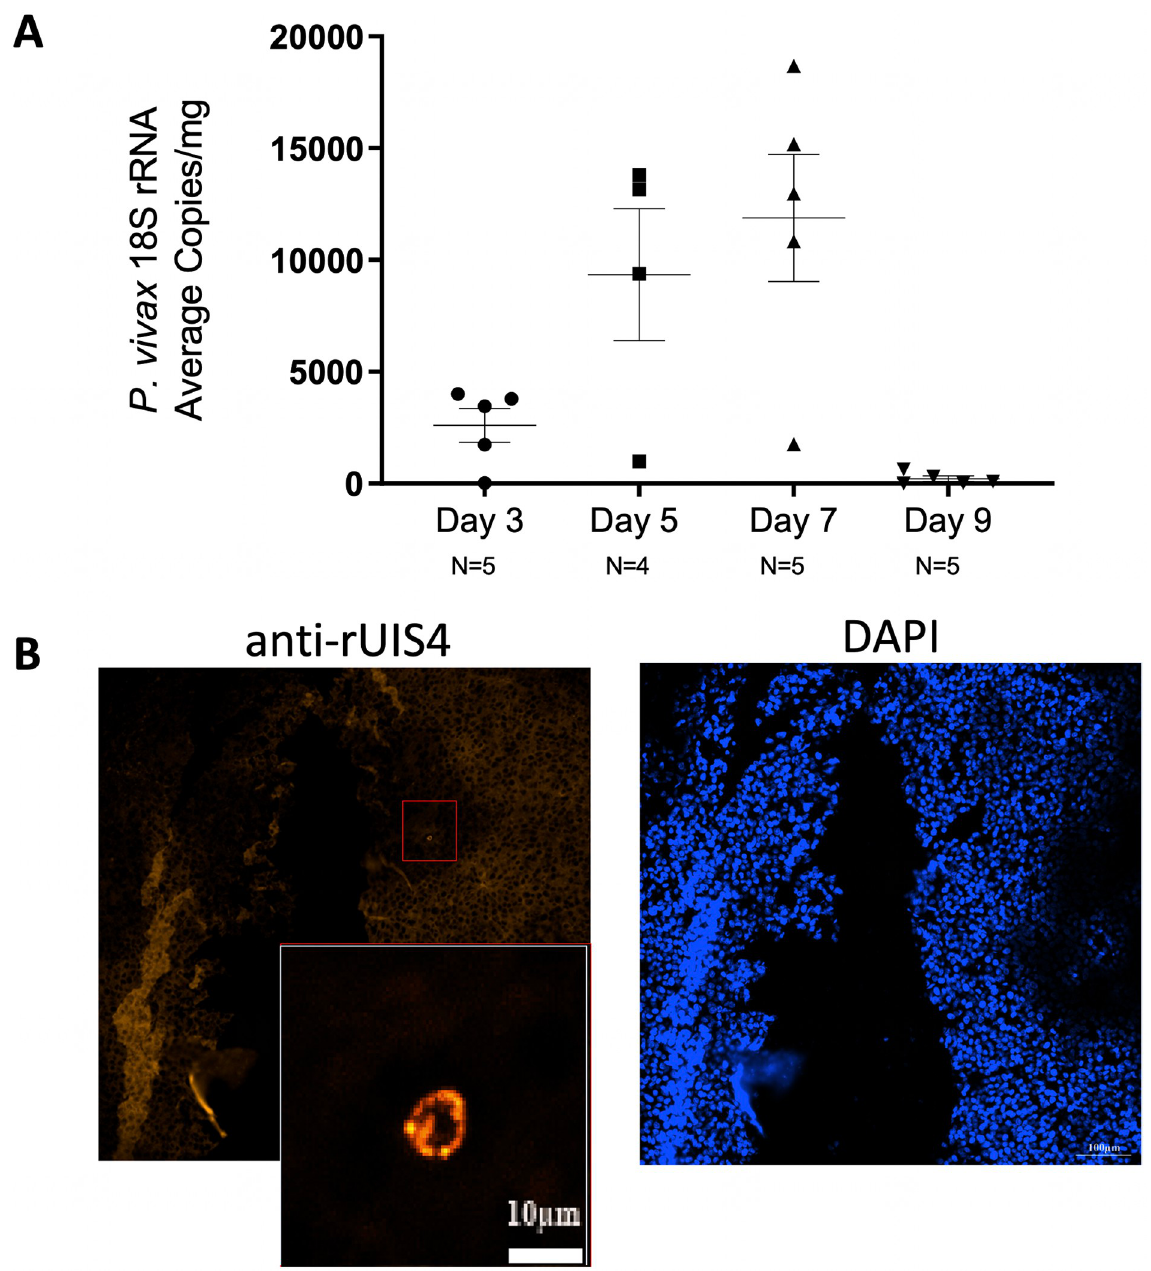
Fig 5. Ectopic huLiver mice infected with freshly dissected P . vivax sporozoites. NSG ectopic huLiver mice were i.v. infected with between 8.8 x 10 5 and 1 x 10 6 P . vivax sporozoites. Mice were euthanized on day 3, 5, 7 or 9 post infection with ectopic liver tissue harvested for IHC and RNA extraction to determine 18s rRNA transcripts levels by qRT-PCR. (A) Quantification of parasite ectopic huLiver burden by qRT-PCR of P . vivax 18S rRNA. (B) Immunohistochemistry analysis at 7 days post infection using anti-rUIS4 and DAPI at 20X magnification. White scale bar represents 100 μ m and grey scale bar represents 10 μ m. https://doi.org/10.1371/journal.pone.0279144.g005 the drawbacks associate with cell-lines [51]. In this model P . falciparum liver stage develop- ment appears to be identical as the one observed in primary human hepatocytes. The draw- back of the model is that P . falciparum infected iHLCs are not responsive to known antimalaria drugs, such as primaquine. This lack of sensitivity is likely attributed to the lack of